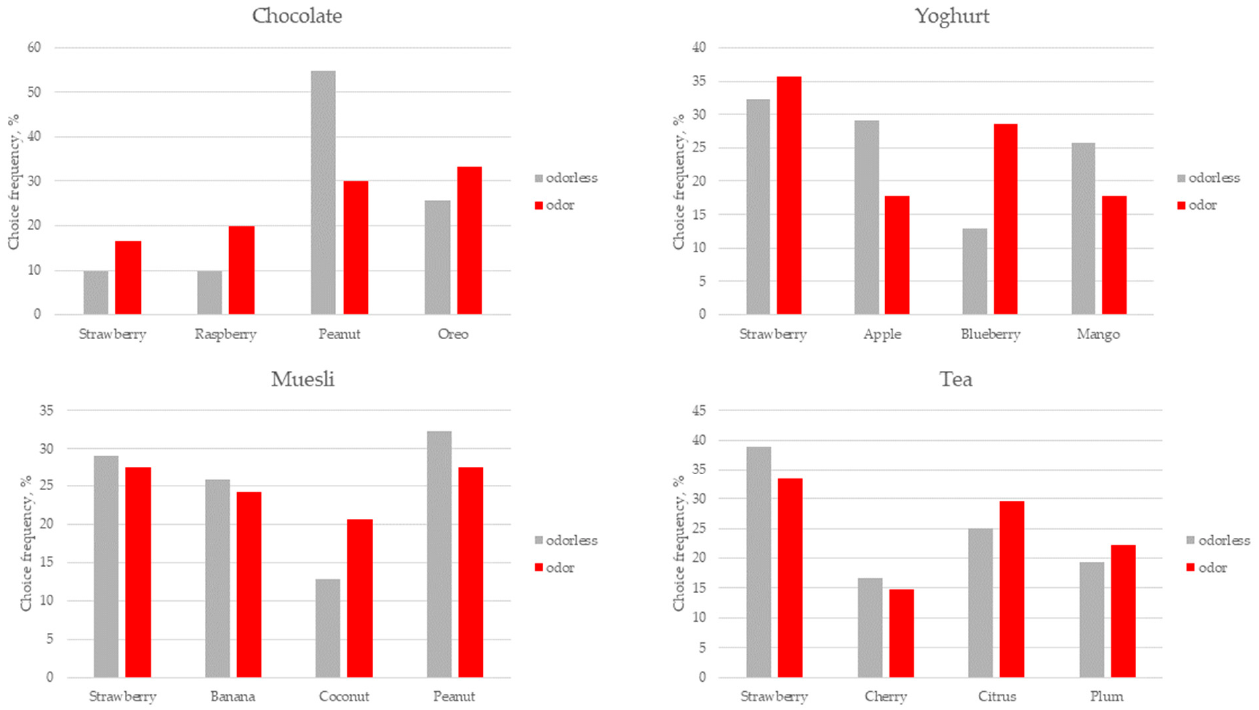
Figure 5. Frequency of choice for all four choice sets with each four alternatives by the two condi- tions.